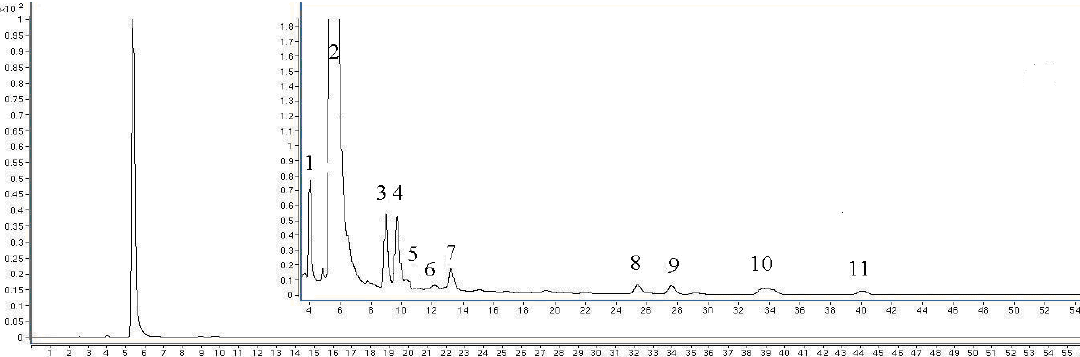
Table 3. Identification of new chromatographic peaks in HPLC-DAD after caffeic acid treatment by ultrasound. Peak